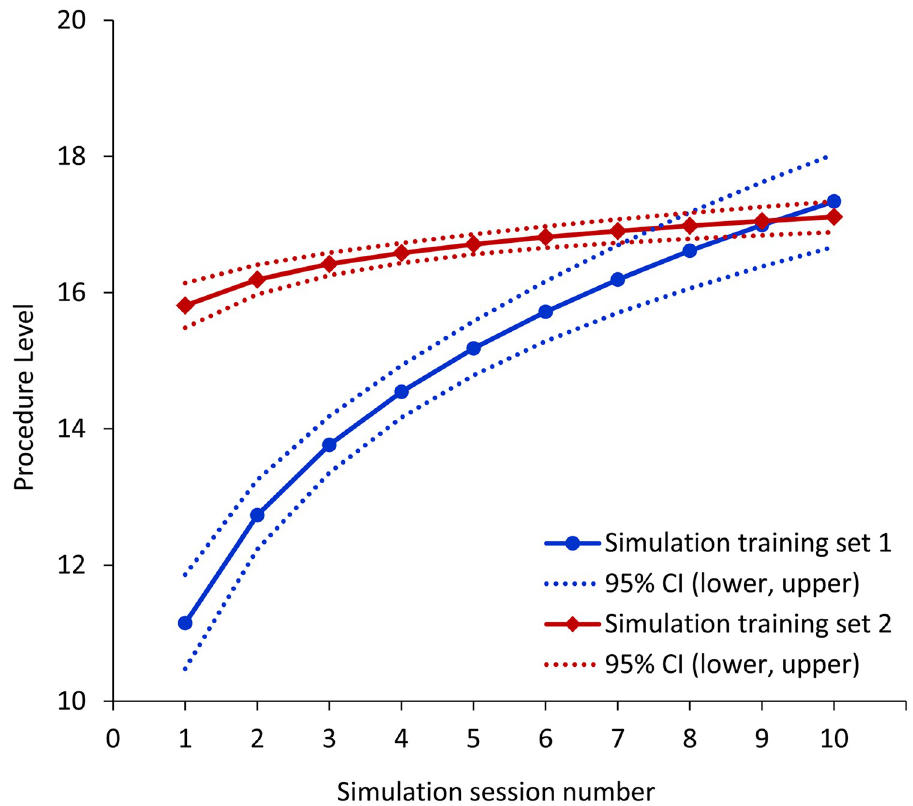
Fig 3. Learning curves for first simulation training set (blue line) and second simulation training set (red line) after one-month inter-training interval. CI, confidence interval.